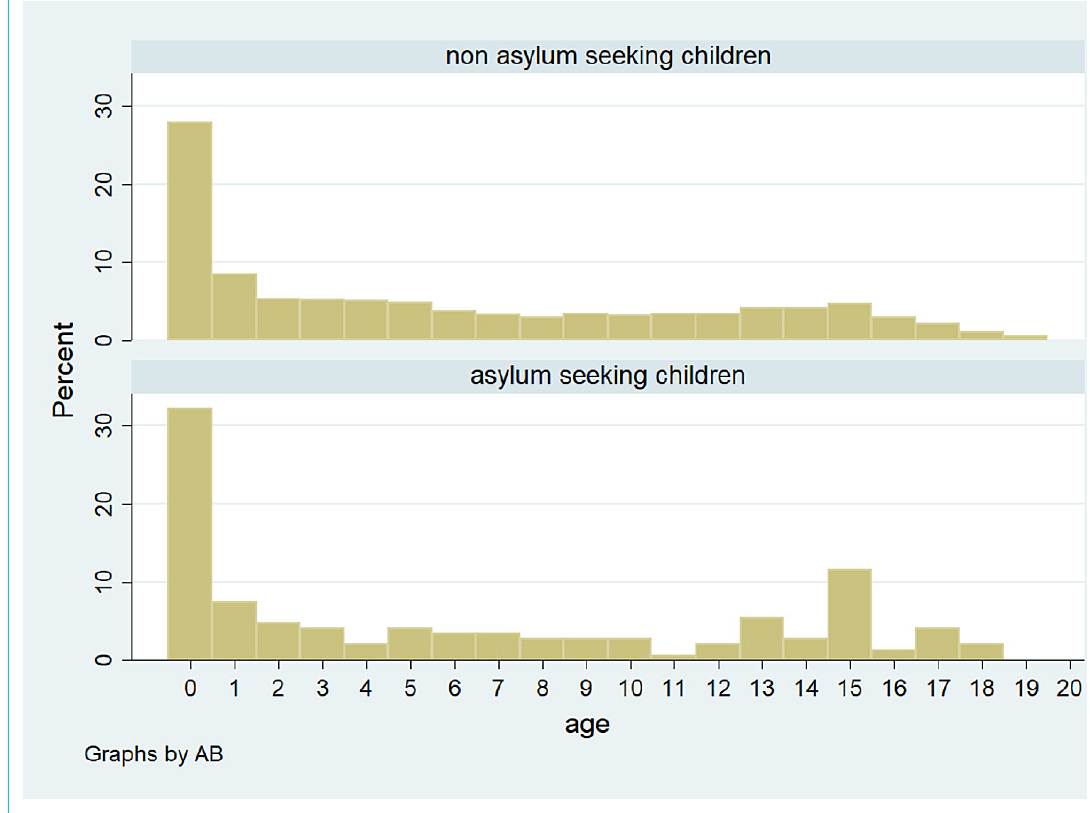
Figure 2: Histogram showing the age distribution of admissions from non-asylum-seeking and asylum-seeking children in the years 2016 and